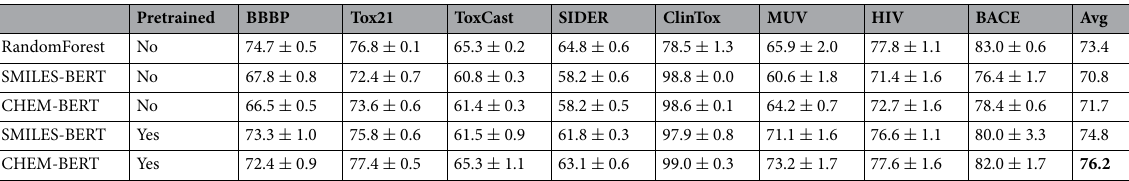
Table 2. ROC–AUC (%) performance on classification tasks. The best score of each dataset is marked as bold.